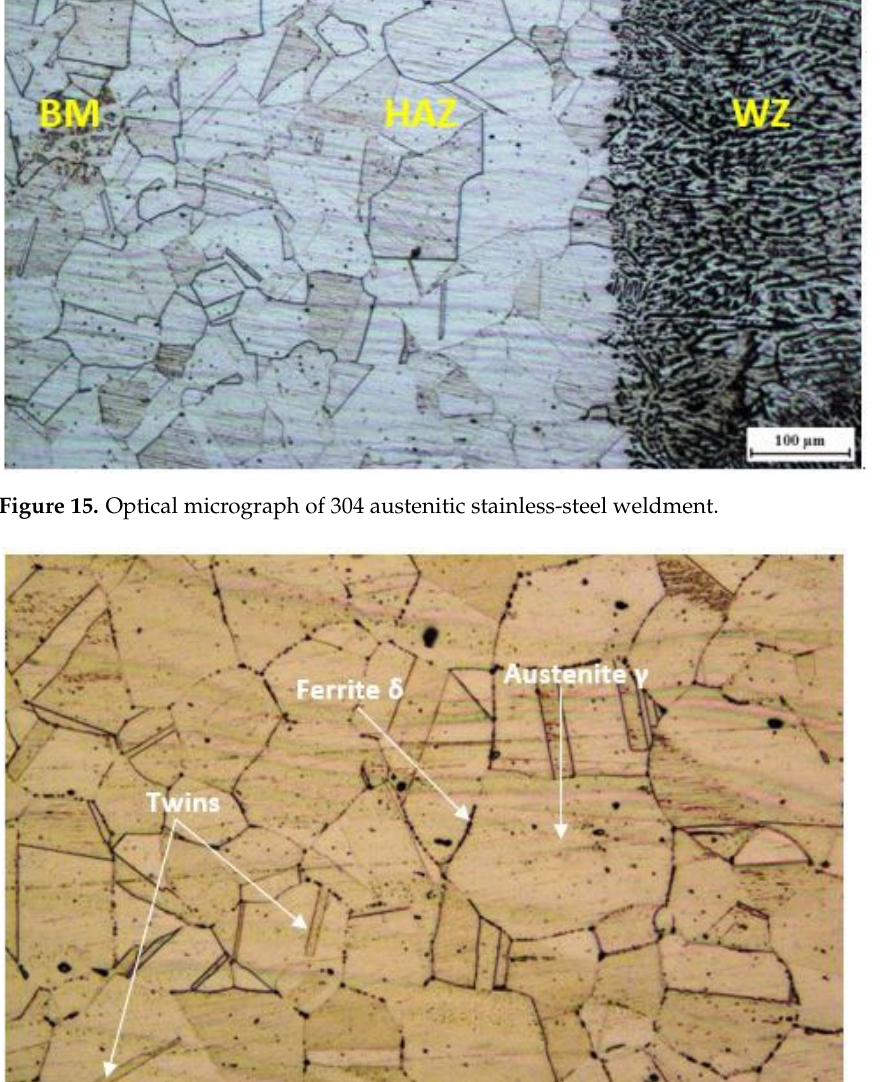
Figure 17. Optical micrograph of the HAZ for 304 austenitic stainless steel. As explicitly illustrated in Figure 18, the structure of the weld metal is very fine in comparison with the BM structure. Indeed, it has a dendritic solidification aspect; it in ‐ volves two phases: the austenitic γ ‐ phase and the δ ‐ ferrite phase. It is characterized by a vermicular morphology [44,45].